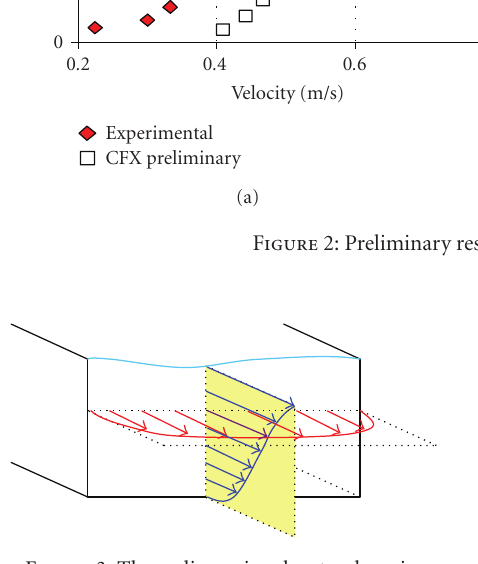
Figure 3: Three-dimensional water domain. Table 1: Details of grids for single-phase